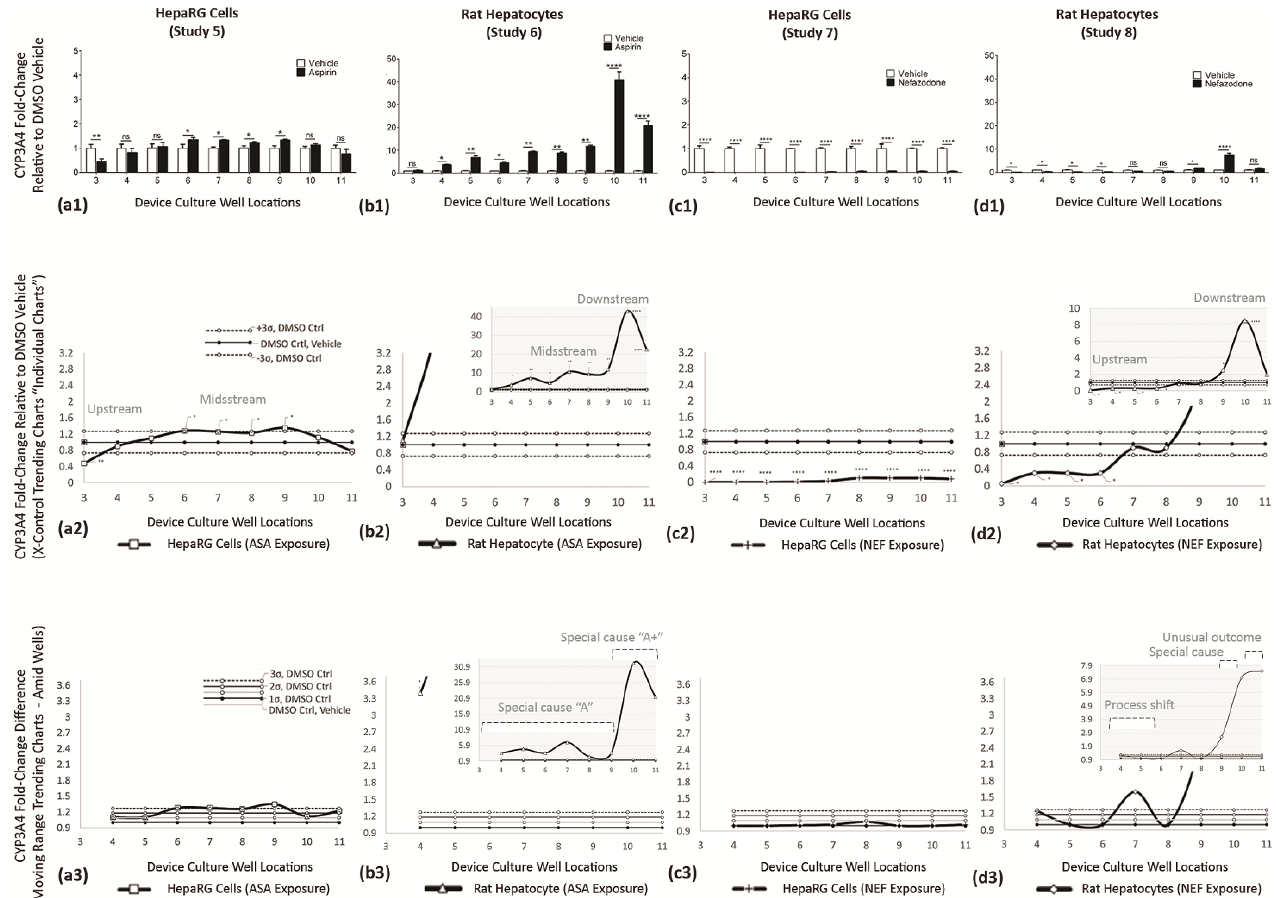
Figure 11. CYP3A4 enzyme activities across multiwell culture locations at Day 7. Activity shown as fold changes (vertical axis) vs. DMSO vehicle control; vehicle normalized at 1. ( a1 , b1 ) Effect of ASA exposure in HepaRG cells and rat hepatocytes. ( c1 , d1 ) Effect of NEF exposure in HepaRG cells and rat hepatocytes. ( a2 , b2 , c2 , d2 ) Re-expression of data using individual trending charts (i.e., X control charts) to convey DMSO controls with drug study outcomes. ( a2—HepaRG line graph ) ASA impedes CYP3A4 at upstream wells 3 (**) then shows upregulated stimulation in midstream wells 6 (*), 7 (*), 8 (*), and 9 (*). ( b2—rat hepatocyte line graph ) ASA has no effect on upstream well 3, then stimulates CYP3A4 across all remaining downstream wells 4 (*)–9 (*) and 10